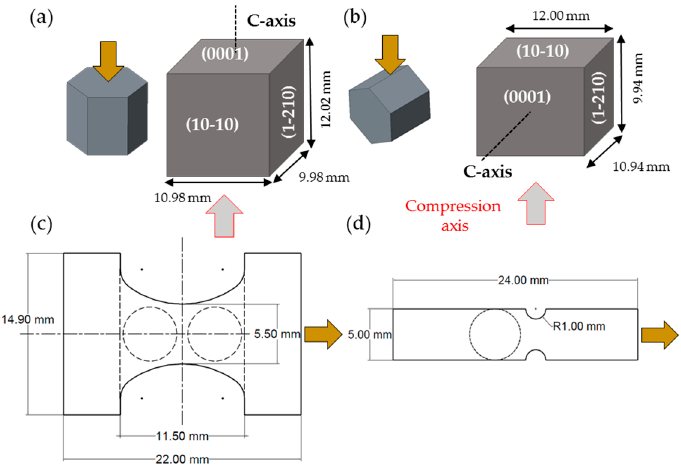
Figure 2. Specimen geometry of: Magnesium single crystal for compression along ( a ) the c -axis and ( b ) along the a -axis; tensile specimens of Magnesium AZ31 used for ( c ) testing inside the SEM and ( d ) using a MTS frame.